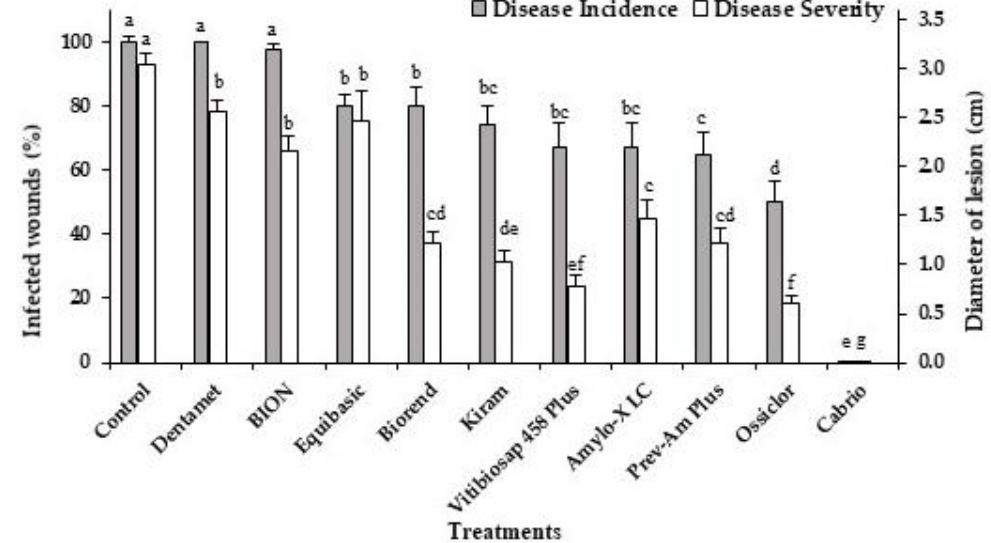
Figure 1. Disease incidence (infected wounds, %) and disease severity (lesion diameter, cm) on citrus fruits cv. “Tarocco Scirè” wounded, treated with alternative products, Ossiclor and Cabrio (1%) and artificially inoculated with C. gloeosporioides . Water-treated fruits were used as a control. Data were recorded after six days of incubation at 25 ± 1 °C and 95 – 98% RH. Bars represent the standard error of the mean (SEM). For each parameter, columns with different letters are statistically different according to Fisher’s least significance difference test (LSD) at p -value < 0.05. Data are the means of two trials.